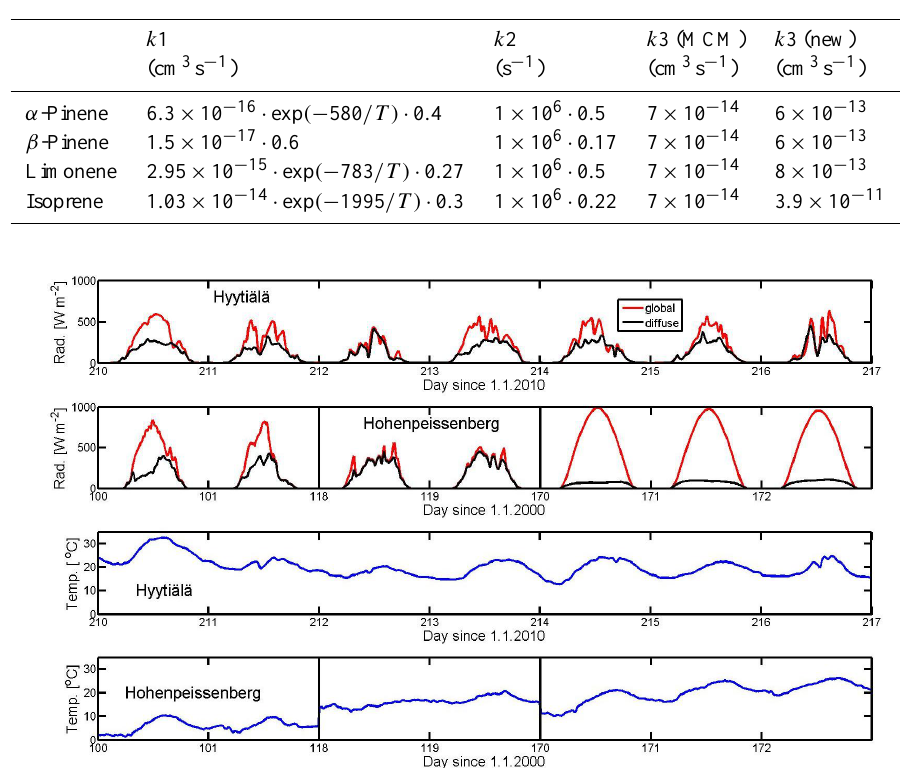
Fig. 1. Measured temperature and global and diffuse radiation for the selected time periods at both